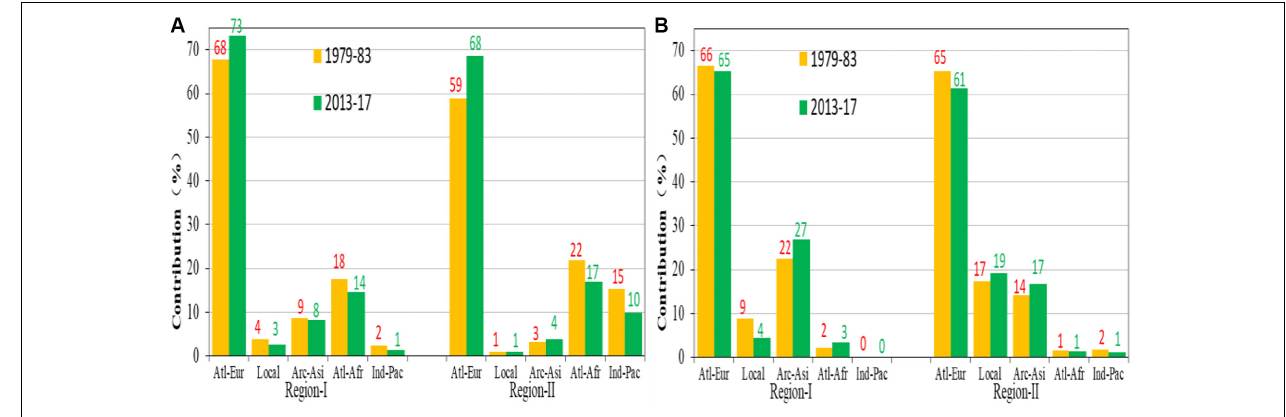
FIGURE 7 | Contribution of moisture at the final positions from various regions in (A) winter and (B) summer during 1979-1983 and